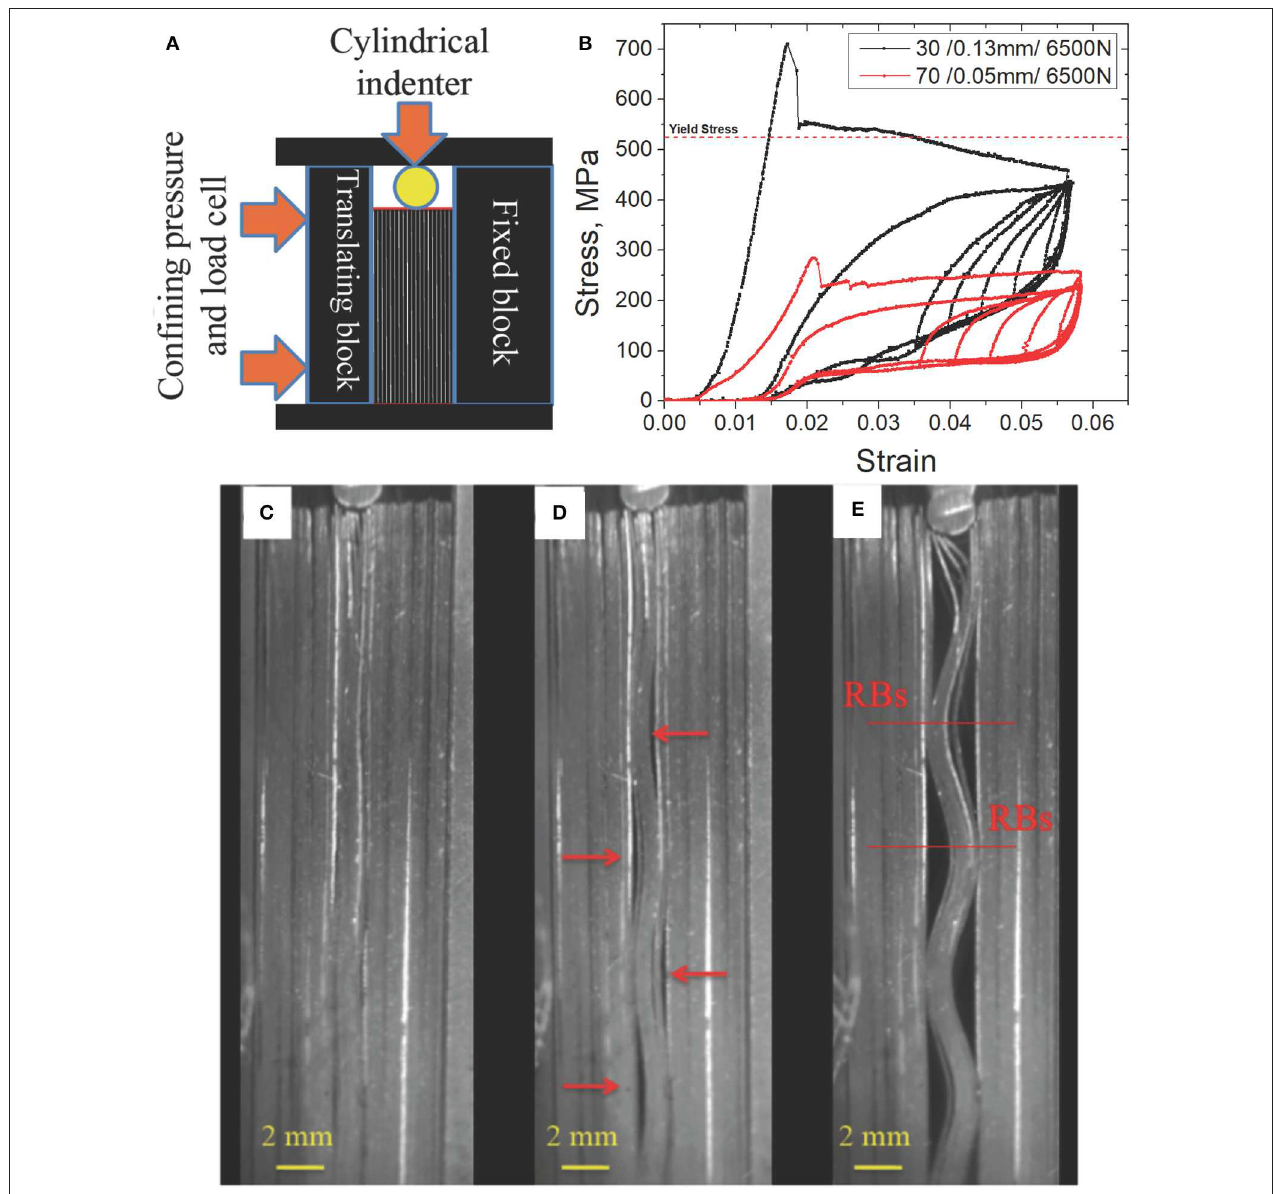
FIGURE 3 | (A) Setup used to study ripplocations in layered systems (Gruber et al., 2016). (B) Typical stress-strain curves of thin steel sheets. Difference between the two curves is in the thickness of the deck and the thickness of the layers in each deck. Confining pressure was the highest used here 6500N (Badr et al., 2020). Drop in maximum stress coincided with buckling and nucleation of RBs. Still frames of movie of loading steel sheets, (C) initial configuration with cylindrical indenter oriented into the page at top. (D) Nucleation of RBs at maximum stress in b. Note delaminations. (E) Same as (D) but at maximum penetration depth. RBs, precursors of kink boundaries, are defined as locus of regions with maximum curvature, i.e., crests of standing waves. Upon removal of the load, the configuration returns to one quite similar to that shown in (A) . Said otherwise the process is